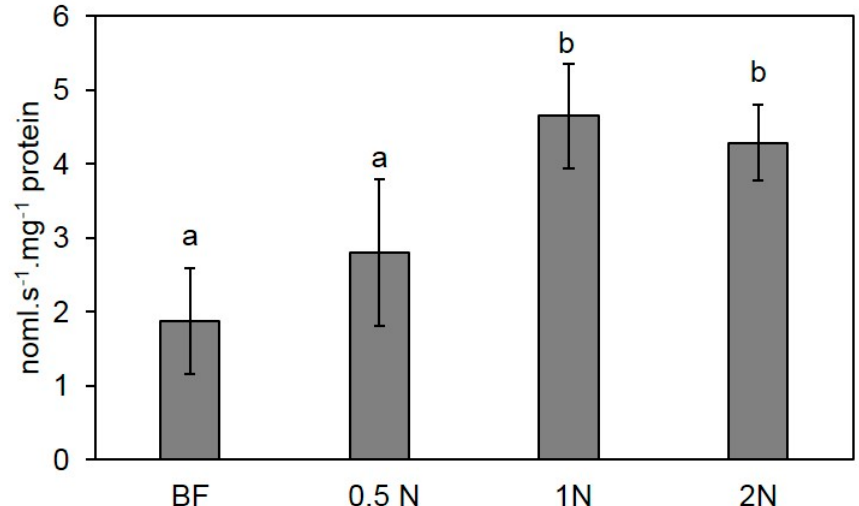
Figure 4. Peroxidase specific activities expressed in nmol.s − 1 .mg − 1 protein in tomato leaves treated with Pleuran complex cell wall extract before inoculation with Botrytis cinerea . The leaves were collected seven days after inoculation. BF: blank formulation; 1N corresponds to a concentration of 350 mg.L − 1 of Pleuran CCWE in the sprayed solution. Data are means of 6 replicates, +/ − standard deviation. Different letters indicate significant differences at p < 0.05.